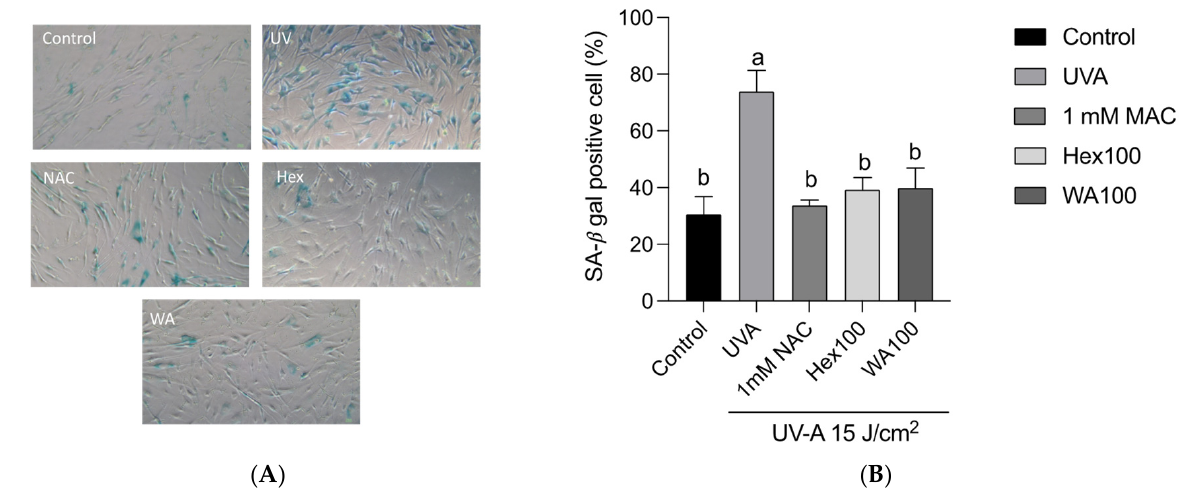
Figure 6. Effect of the fractions of fermented turmeric milk extract on SA- β -gal activity in UVA- irradiated Hs68 cells. ( A ) Microscopy images of senescent Hs68 cells shown by SA- β -gal staining (400× magnification). ( B ) SA- β -gal activity was quantified by the percentage of SA- β -gal-positive cells in total Hs68 cells. Superscripts indicate significant differences in one-way analysis of variance (ANOVA) and Tukey’s multiple range test ( p < 0.05). SA- β -gal: senescence-associated β -galactosidase. NAC: N-acetylcysteine group. Hex100: 100 ppm of hexane fraction of fermented turmeric